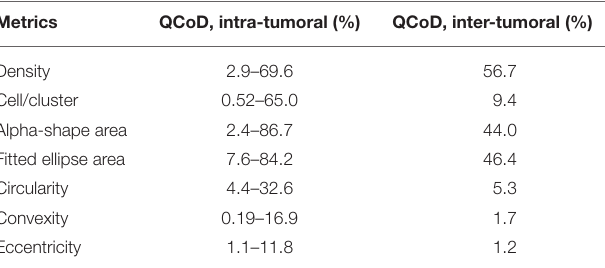
TABLE 2 | Intra- and inter-tumoral QCoD for cluster statistics and shape